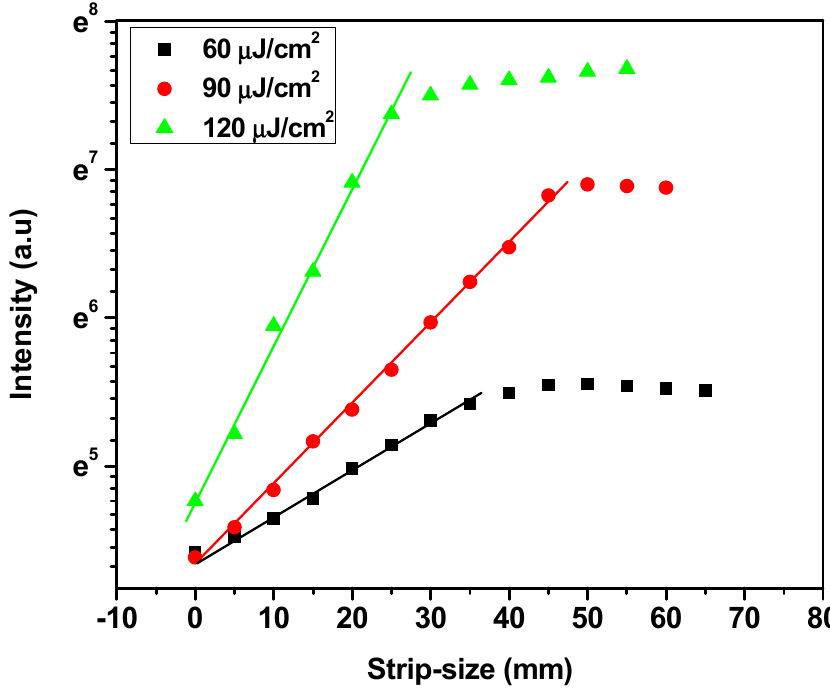
Figure 6. Gain characteristics for P5T waveguide optical amplifiers.